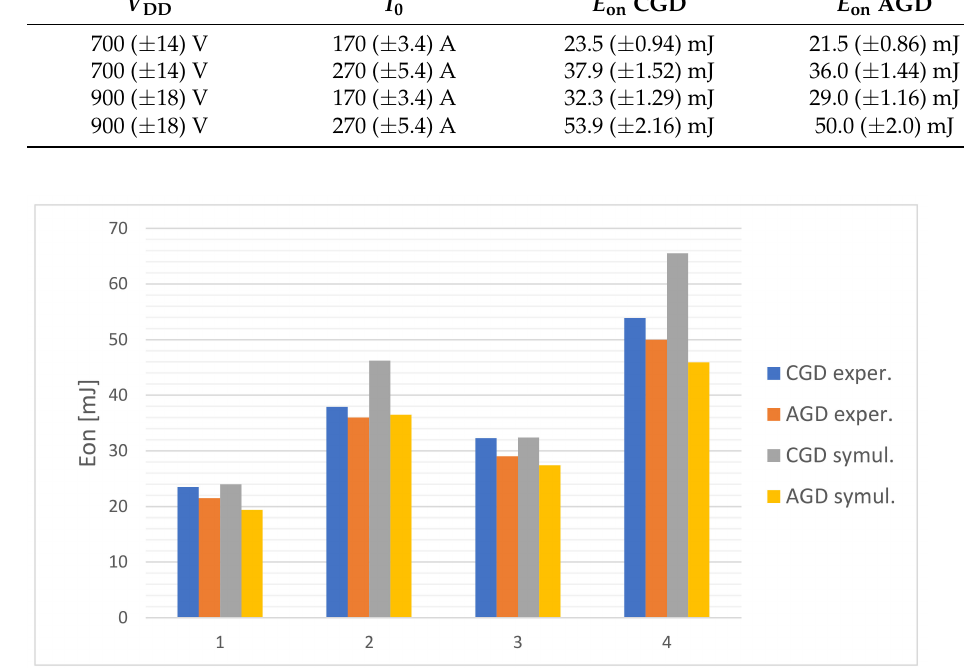
Figure 13. Chart of the turn-on energy for CGD and AGD both in experimental and simulation conditions. 1— V DD = 700 V, I 0 = 170 A, 2— V DD = 700 V, I 0 = 270 A, 3— V DD = 900 V, I 0 = 170 A, and 4 —V DD = 900 V, I 0 = 270